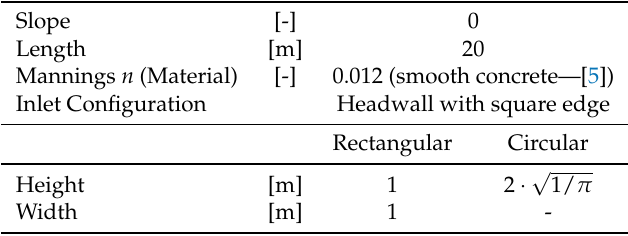
Table 1. Standard properties for investigated culvert. Unless stated otherwise, these values were used for all